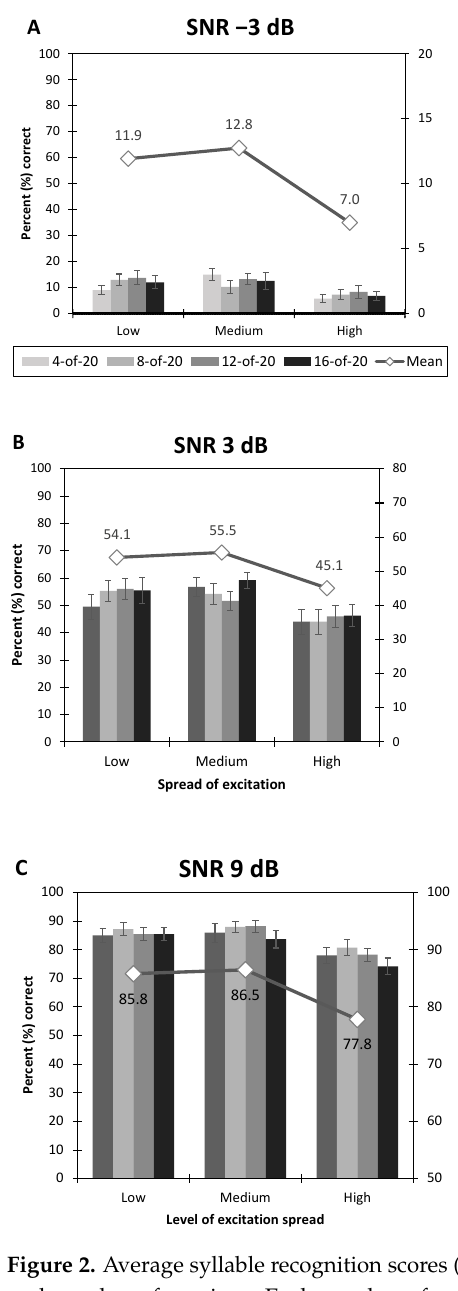
Figure 2. Average syllable recognition scores (in percent correct) function of the spread of excitation and number of maxima. Each number of maxima is represented by a different grey bar, and av- erage performances for a single level of spread of excitation (across the number of maxima) are represented by a grey line with diamonds. The left scale is for the bars and scale on the right, is for the averages across maxima. ( A ) Condition − 3 dB of signal-to-noise ratio, ( B ) Condition 3 dB SNR, and ( C ) Condition 9 dB SNR. Error bars represent ± 1 standard error of the mean.